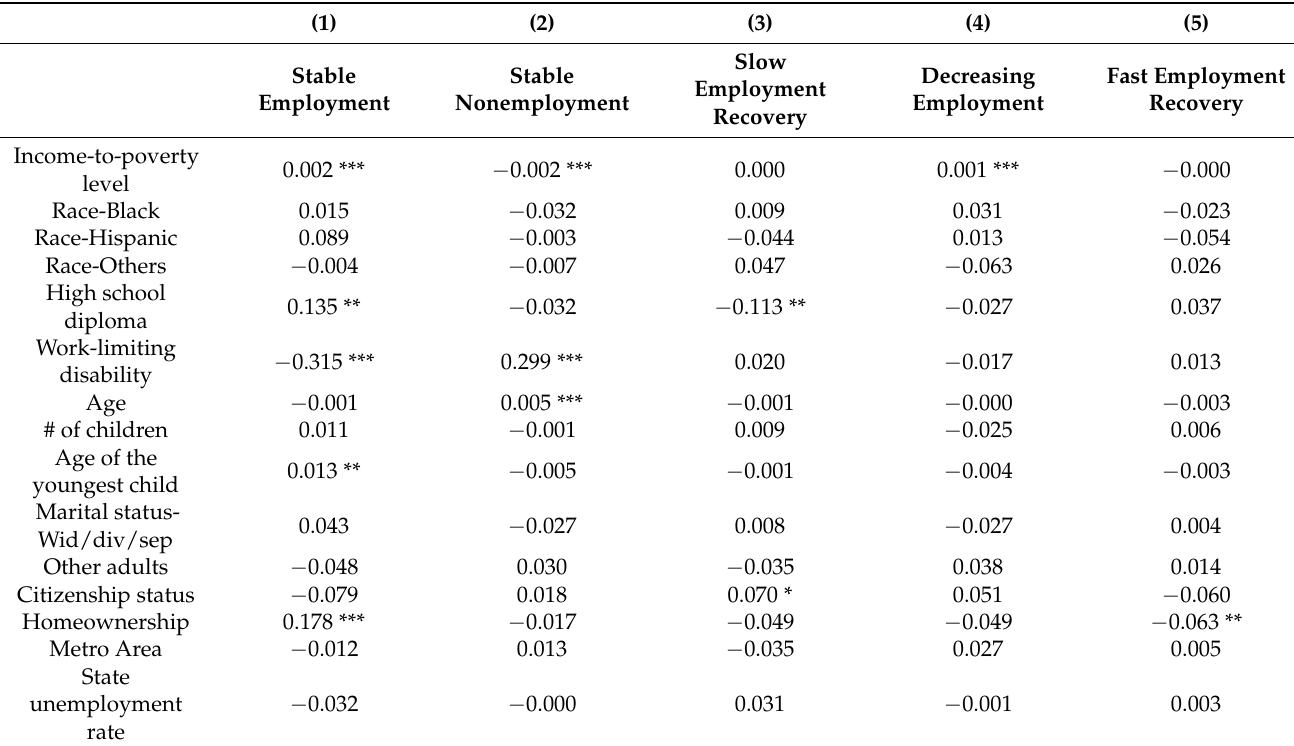
Table 2. Average Marginal Effects of Baseline Sociodemographic Characteristics on the Probabilities of Group Membership (N =